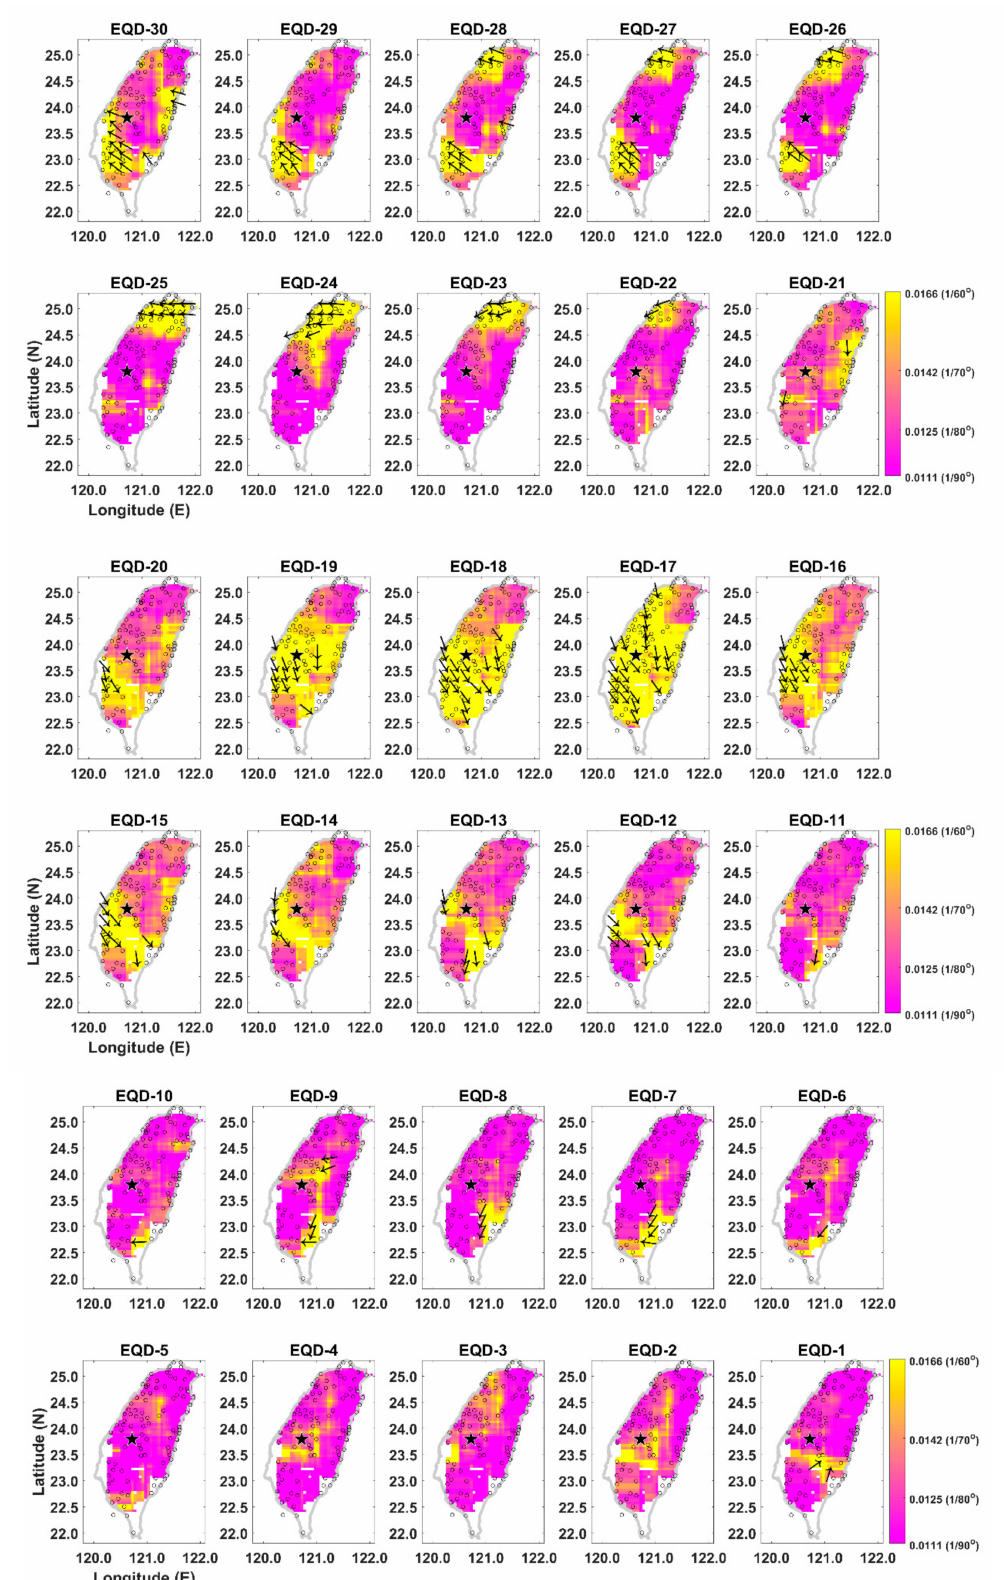
Figure 9. Maps of θ w from 30 to 1 days before the earthquake day (EQD) of EQ28. The largest black star is the CWB-published epicenter of the EQ28. The pink and yellow colors denote areas of small (~0.011) and large (~0.02) θ w ’ , respectively. Black arrows show the direction of surface